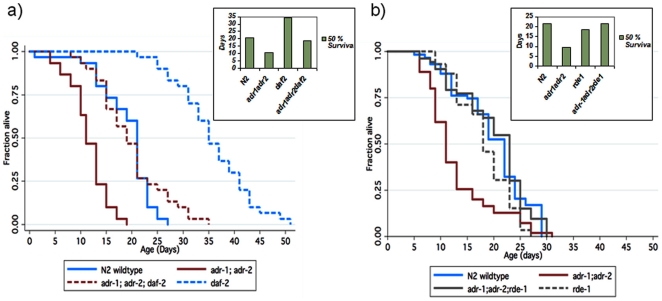

ADAR mediated decline in lifespan, daf-2 influence, and rde-1 rescue.a) Lifespan using mutant strains for adr-1;adr-2 in the context of dsRNA mediated gene inactivation of daf-2. Synchronized worms at the larval stage 4 (L4) were sterilized with FudR and allowed to feed on bacterial lawns that contained dsRNA for daf-2. Note: adr-1; adr-2 double mutant (red solid), adr-1; adr-2 double mutant with dsRNA for daf-2 (red hatched), N2 wild type (blue solid), N2 with dsRNA for daf-2 (blue hatched). Note decline in lifespan due to adr-1; adr-2 compared with N2 wildtype. Also note increases in lifespan of both N2 and adr-1; adr-2 in the presence of dsRNA for daf-2. The 50% survival time in the adr-1; adr-2 mutant animals was 10 days (95% limits 9 and 12 days) compared with 20 days (95% limits 18 and 20 days) for N2 wild-type control worms. RNAi to daf-2 increases lifespan to 34 days (95% limits 32 and 40 days), compared with 20 days for the wild type (N2 worms fed empty vector (RNAi)). daf-2 gene inactivation, in the background of the adr-1 and adr-2 null mutations also restored lifespan to 18 days (95% limits 16 and 20 days), compared with 10 days for the adr-1;adr-2 double mutant strain. b) Lifespan using mutant strains for adr-1;adr-2 (solid red), N2 wildtype (solid blue), rde-1 (grey hatched), adr-1; adr-2; rde-1 (grey solid) demonstrate declines in lifespan using mutant strains and full rescue of lifespan in an RNAi defective (rde-1) background. The adr-1; adr-2 mutant was again about half as long lived as wild-type (median survival time 9 days for adr-1;adr-2 strain (95% limits 9 and 11 days), and median survival time 21 days (95% limits 18 and 21 days), for N2 wild-type worms. The survival distribution of the triple mutant adr-1;adr-2; rde-1 is median lifespan 21 days (95% limits 18 and 21 days), which is significantly different from adr-1;adr-2, with a median lifespan of 9 days (95% limits 9 and 11 days). The lifespan of rde-1 was modestly reduced compared with the wild-type N2, as was reported previously29. Inset boxes displays 50% survival (days) for each condition and demonstrates that daf-2 gene inactivation increases lifespan, in both wild type and in adr-1;adr-2 mutant strains (a) and that RNAi knockout (rde-1) restores lifespan.